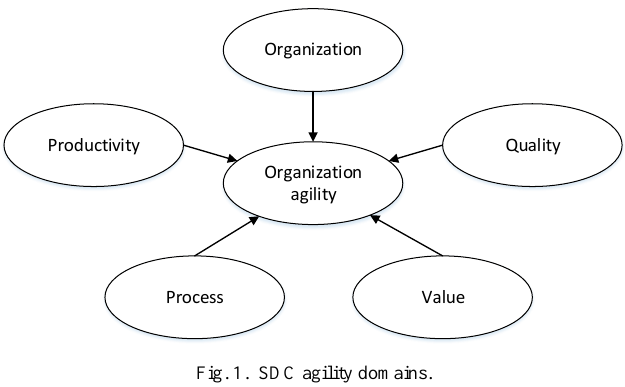
Fig. 1. SDC agility